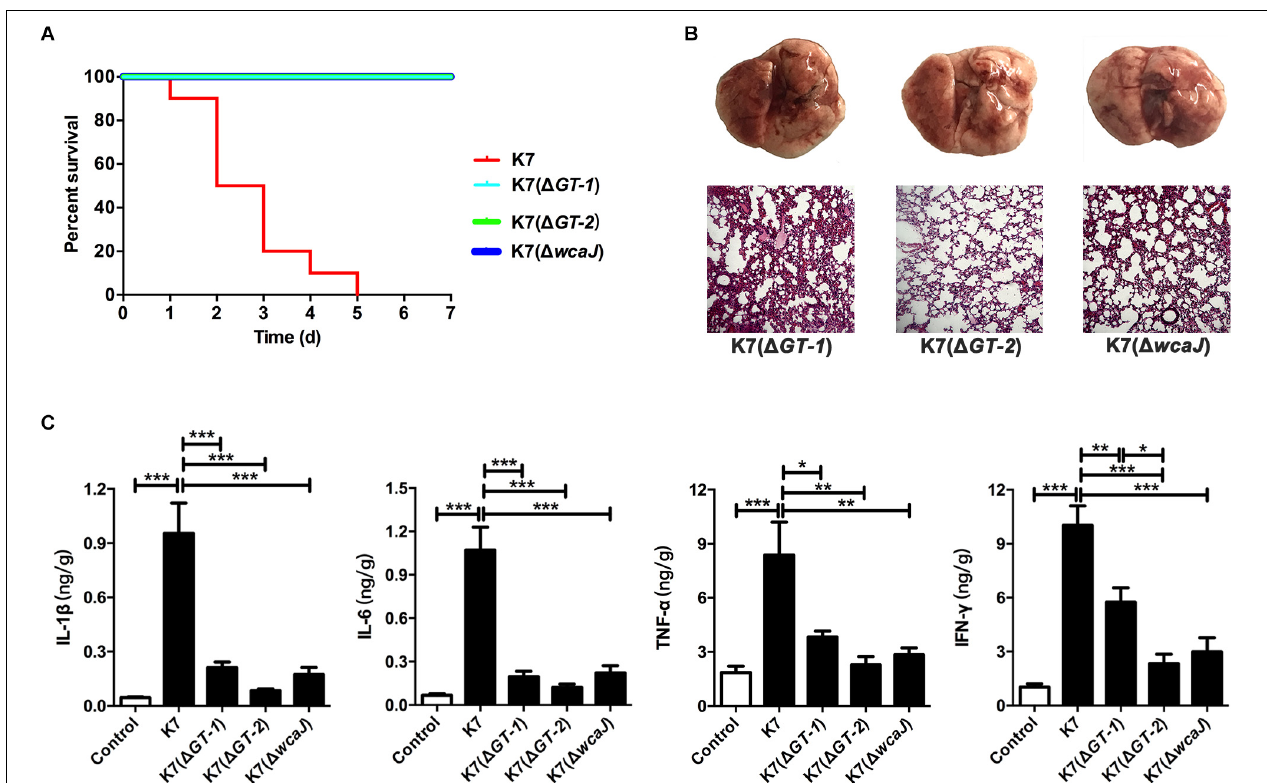
FIGURE 6 | Virulence evaluation of K. pneumoniae K7( (cid:49) GT-1 ), K7( (cid:49) GT-2 ), and K7( (cid:49) wcaJ ). All the mice were challenged intranasally with 1 × 10 7 CFU/mouse of K. pneumoniae K7, K7( (cid:49) GT-1 ), K7( (cid:49) GT-2 ), and K7( (cid:49) wcaJ ). (A) Survival rates. Survival rates of mice challenged with K. pneumoniae K7( (cid:49) GT-1 ), K7( (cid:49) GT-2 ), and K7( (cid:49) wcaJ ) were determined. Each group contained ten mice. Statistical analysis was performed using the Kaplan–Meier method by [ P < 0.0001, log-rank (Mantel-Cox) test]. (B) Pathological observation. At 48 h after infection, the lungs of mice challenged with K. pneumoniae K7( (cid:49) GT-1 ), K7( (cid:49) GT-2 ), and K7( (cid:49) wcaJ ) were carefully removed and photographed after euthanasia. Lung tissue sections were stained with H&E and then observed in a microscope at a magnification 100 × . Lung tissues of healthy mice were served as controls. (C) The levels of four cytokines. The levels of IL-1 β , IL-6, TNF- α , and IFN- γ in lung tissue homogenates of mice infected by K. pneumoniae K7( (cid:49) GT-1 ), K7( (cid:49) GT-2 ), and K7( (cid:49) wcaJ ) were determined. Lung tissue homogenates of healthy mice were served as controls. ∗ , ∗∗ , and ∗∗∗ represent significant differences at P < 0.05, P < 0.01, and P < 0.001, respectively. Data represent the mean ± SEM of triplicate